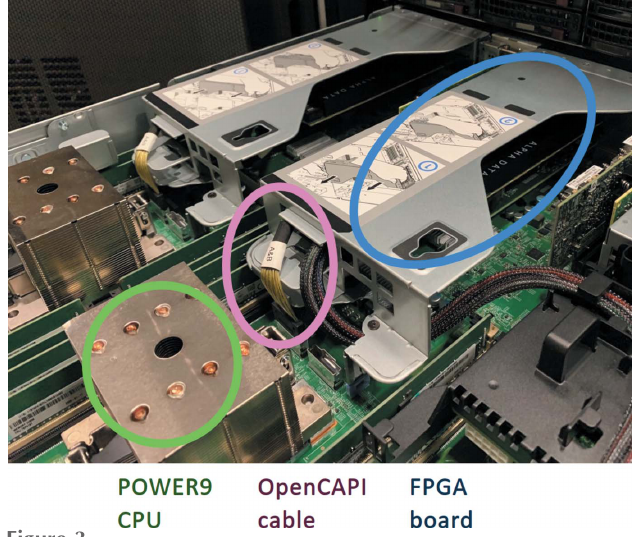
Figure 3 A photograph of the IC922 server (IBM). The OpenCAPI interface over a dedicated cable allows the FPGA to coherently access the memory of the host